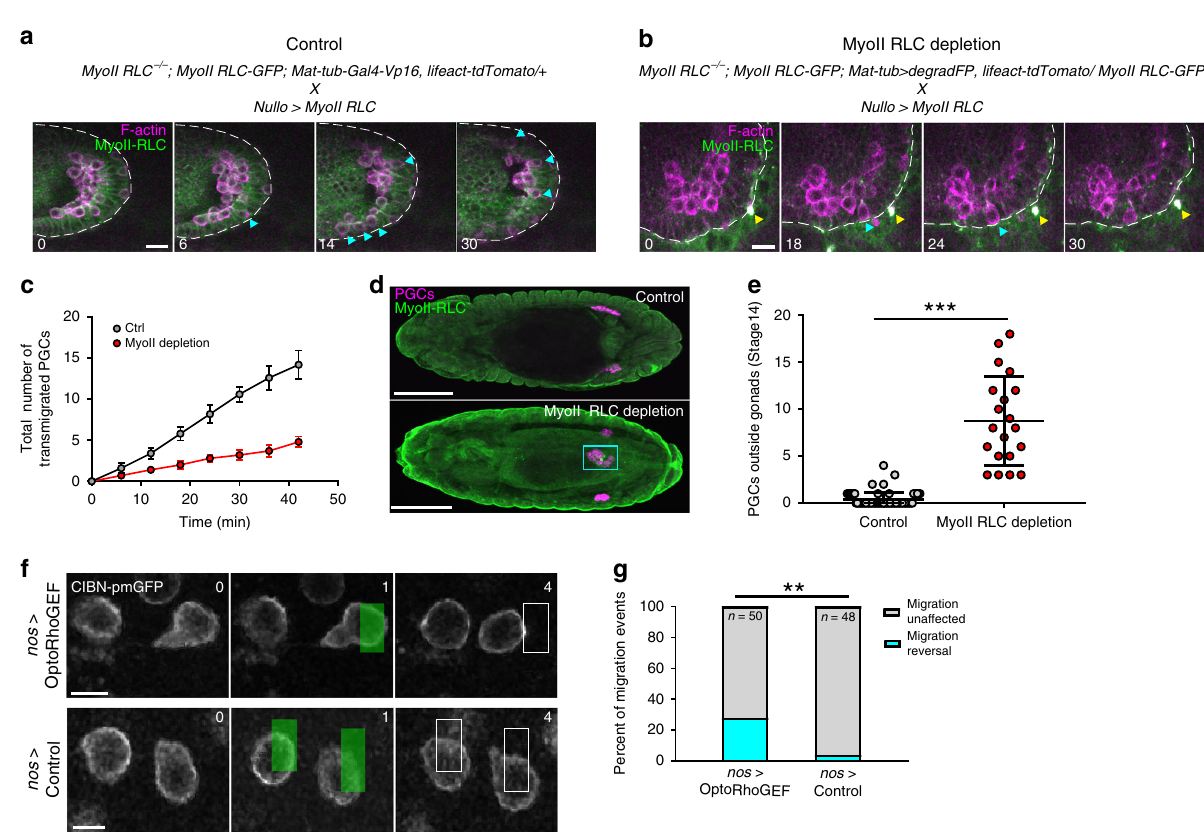
Fig. 5 Myosin II is necessary for PGC dispersal and its local accumulation can redirect migration. a , b Two photon timelapse imaging of a representative control and Myosin II RLC depleted PGC cluster for 30 min after endoderm EMT. A single Z slice is shown. White dotted lines trace the boundary of the endoderm. Cyan arrows indicate PGCs which have transmigrated. Yellow arrow indicates a myosin II RLC-GFP inclusion body, which has been observed previously after degradation. Representative images are from n = 5 embryos in ( a ) and n = 10 embryos in ( b ). Times are in minutes. Scale bars, 10 μ m. c Quanti fi cation of the total number of PGCs which have transmigrated over time under the indicated conditions. n = 10 embryos for myoII depletion and n = 5 embryos for control. Error bars are SEM. d Representative confocal images of immunostained stage 14 embryos under the indicated conditions. Representative images are from n = 65 embryos in control and n = 20 embryos in myoII depletion. Scale bars, 100 μ m. e Quanti fi cation of the number of PGCs outside the gonad at stage 14 of embryogenesis. n = 65 control embryos and n = 20 myoII RLC depletion embryos. Data are presented as mean values + / − SD. Statistical comparisons are from a Mann – Whitney test with p < 0.0001. *** p < 0.001. f Two photon timelapse imaging of representative PGCs expressing the OptoRhoGEF (RhoGEF2-CRY2-mCherry, CIBn-pmGFP) system (top) or control (CIBnpmGFP) (bottom) migrating to the anterior (right) at stage 11 of embryogenesis. A single Z slice is shown. Green box indicates region which was pulsed with 950 nm light. The white rectangle in the following frame indicates the position of the pulse at time t = 1. Representative images are from n = 9 embryos in OptoRhoGEF and n = 10 embryos in control. Times are in minutes. Scale bars, 10 μ m. g Quanti fi cation of the percent of migration events which occur after a blue light pulse under the indicated condition. Number of pulses are indicated. n = 27 PGCs from 9 embryos for OptoRhoGEF and n = 25 PGCS from 10 embryos for control. Statistical comparisons are from a Fisher ’ s exact test with p = 0.0019. ** p < 0.01. Source data from ( c , e and g ) are provided as a Source Data fi